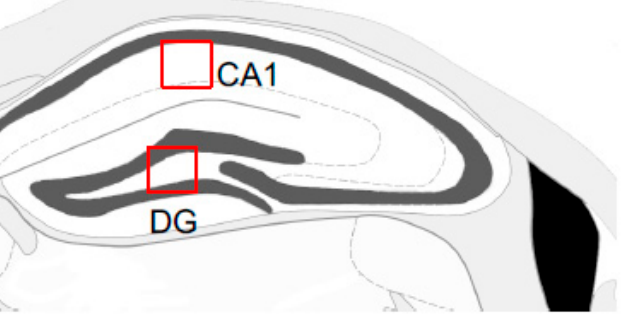
Figure 3. Schematic of dorsal hippocampus showing regions sampled for EM. The stratum radiatum of CA1 (top box) and the hilus of the dentate gyrus (DG; bottom box) were sampled for EM. Bregma level ~2.10 mm (modified from Allen Brain atlas https://atlas.brain-map.org (accessed on 4 December 2020)).